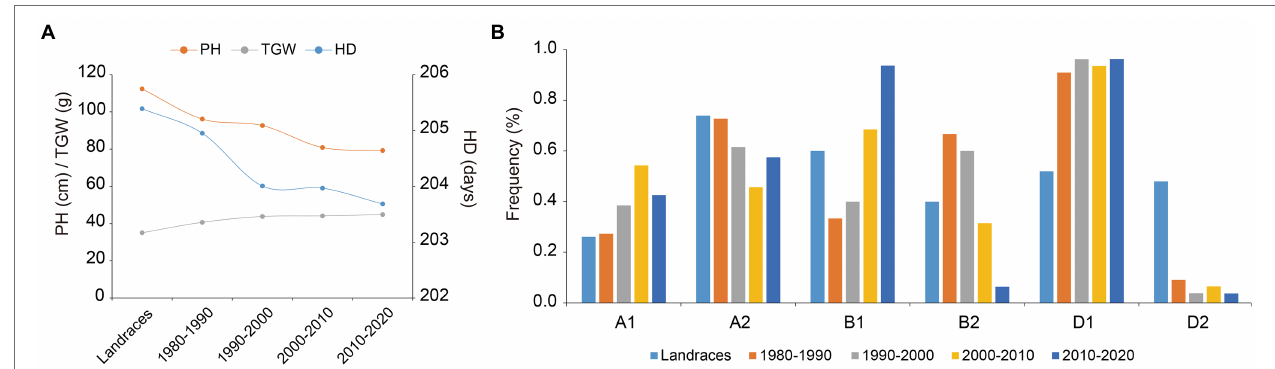
FIGURE 5 | Favorable haplotypes of Ppd-1 were selected for in wheat breeding programs. (A) Changes in PH, TGW, and HD in 188 accessions over decades in landraces and modern cultivars. In this population, 25 landraces are represented, as were 9, 26, 75, and 53 cultivars released in the 1980s, 1990s, 2000s, and 2010s, respectively. Data for PH, TGW, and HD are represented by the line chart using the BLUE mean under seven environments. (B) Frequency of Ppd-A1 , Ppd-B1 , and Ppd-D1 haplotype changes over decades in landraces and modern